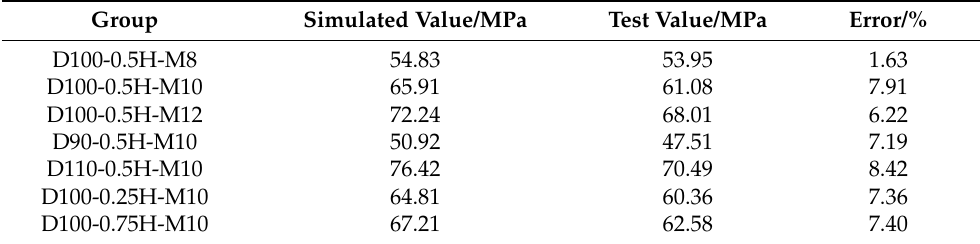
Figure 11. Comparison of the simulated and tested load – strain curves of the composite joints. ( a ) Load – strain curves under different bolt diameters; ( b ) Load – strain curves under different bamboo outer diameters; ( c ) Load – strain curves under different edge distances. Table 4. Comparison of the simulated strength and test strength.